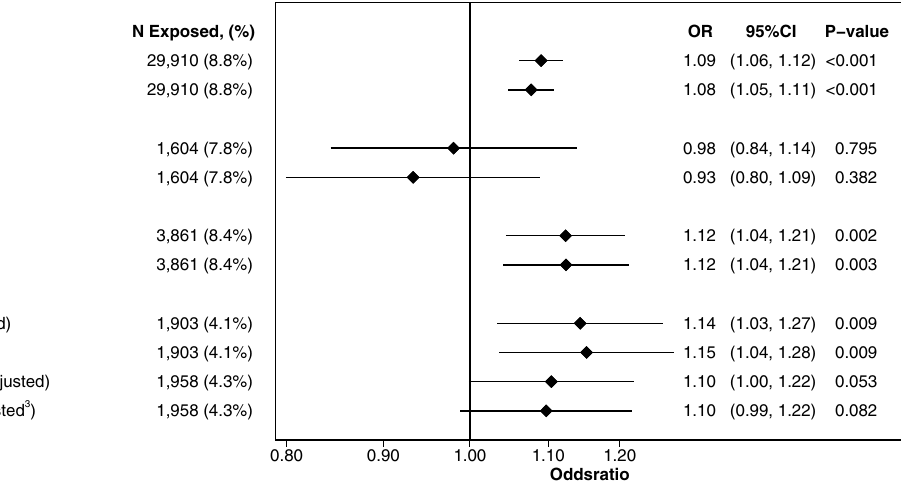
Figure 3. Association between cesarean section and low cardiorespiratory fitness at conscription in the 18th life-year for the main analytic sample, within-family analyses and analytic sub-population. Superscript 1: Adjusted models in main analyses show logistic regression estimates of odds ratios of low CRF (defined as lowest quartile of Wmax achieved by all recruits during the study period), 95% confidence intervals and p-values between individuals born through cesarean section (elective and non-elective combined) as compared to all individuals born vaginally. Adjustments included: birthweights standardized according to gestational age, gestational age, maternal age, parity, maternal diseases (diabetes, hypertension, preeclampsia, SLE), highest parental educational level, household disposable income, parental country of birth and highest